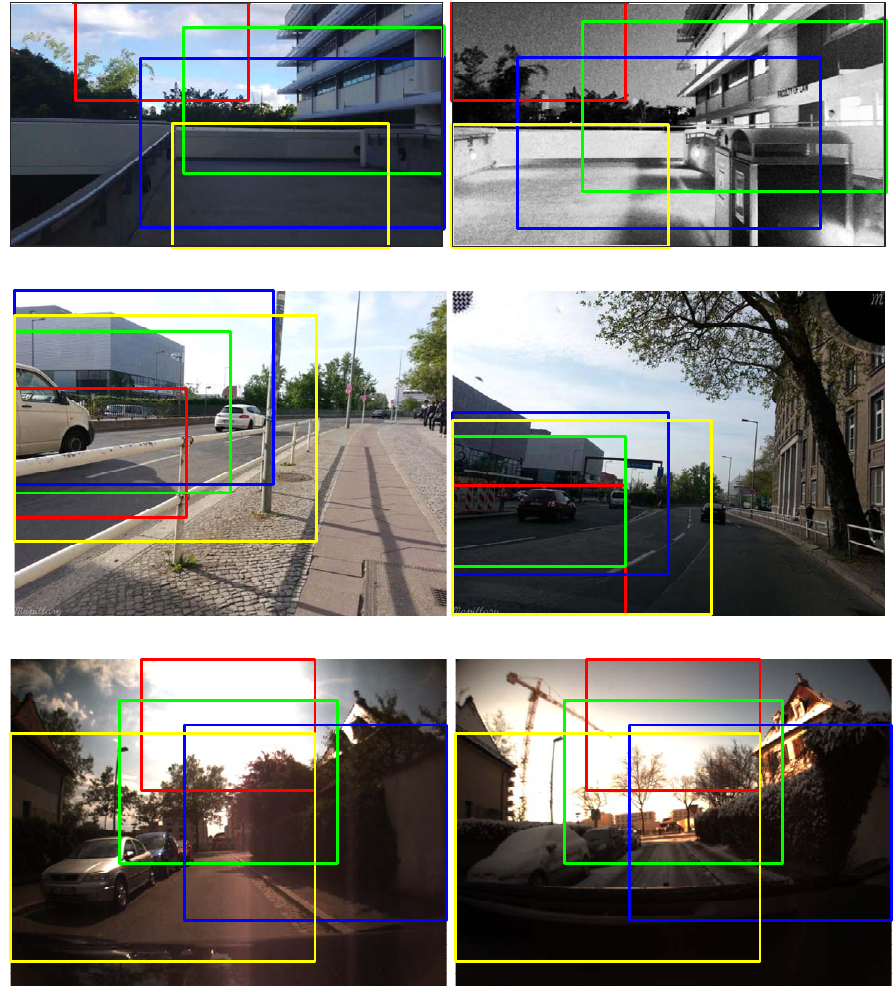
Figure 1. Three examples of the pairwise matching using our approach. Each row presents two correctly matching images while the boxes outlined with the same color in two images denote the successfully matched landmarks. It shows that the landmarks generated using our method is robust to dramatic illumination, viewpoint and seasonal changes (from top to bottom